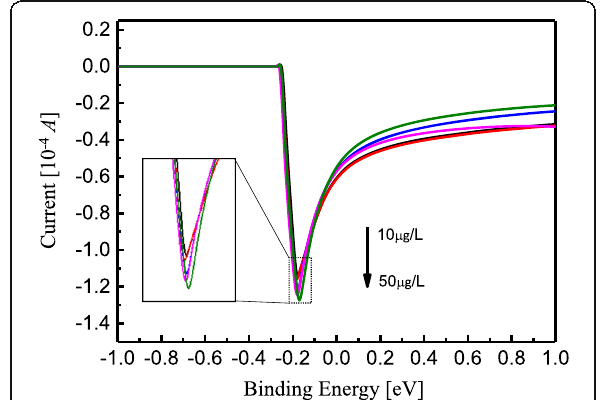
Fig. 5 The dissolve current dependence of the voltage when detected Fe 3+